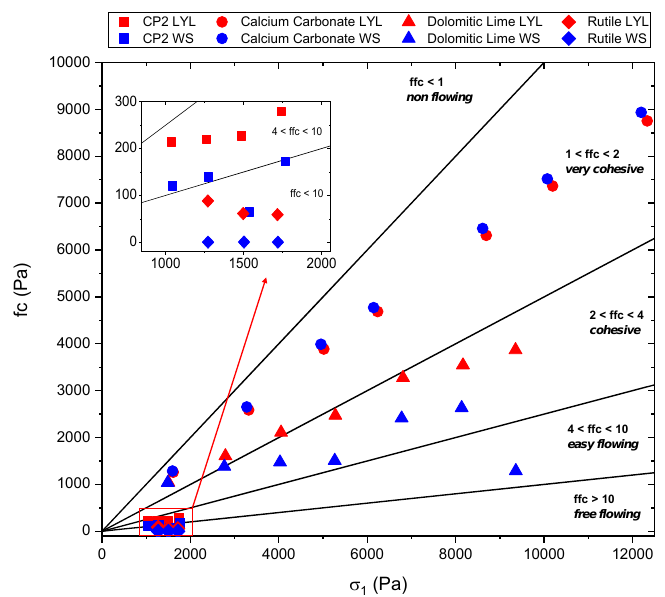
ff erent model yield